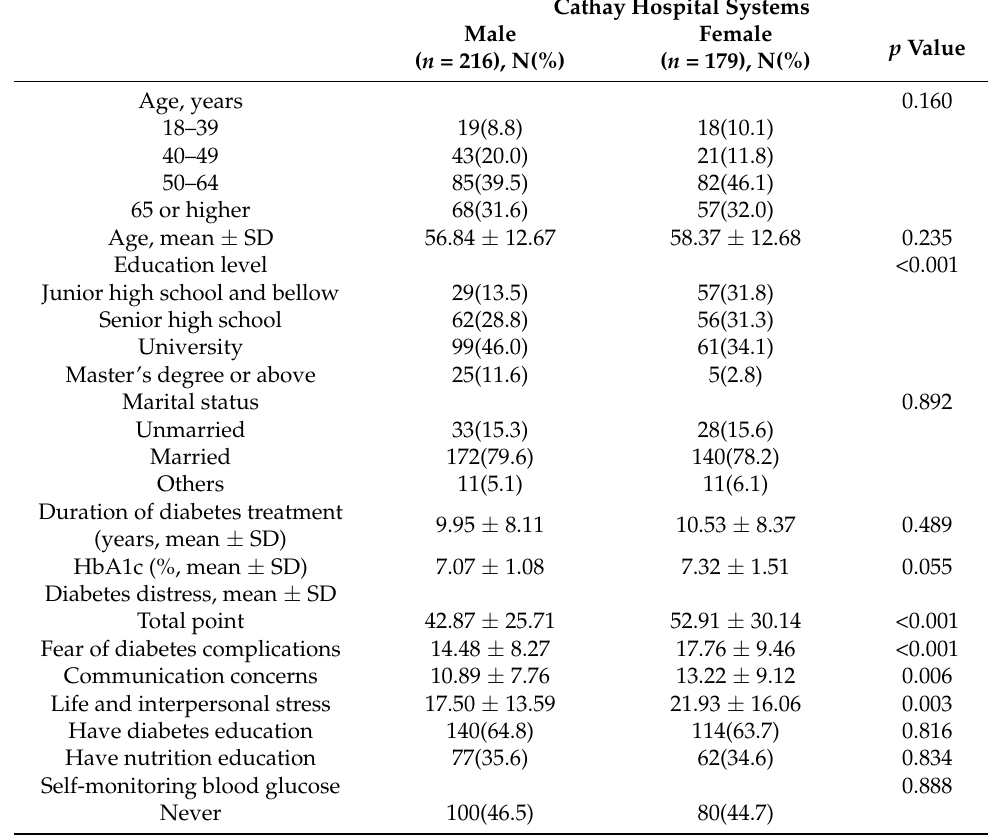
Table 1. Demographic characteristics and health status of